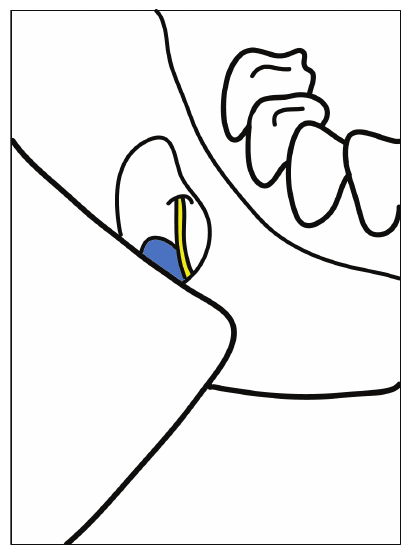
F 3: �iagrammatic representation of intraoperative �ndings of chin implant (blue) inferior to mental nerve